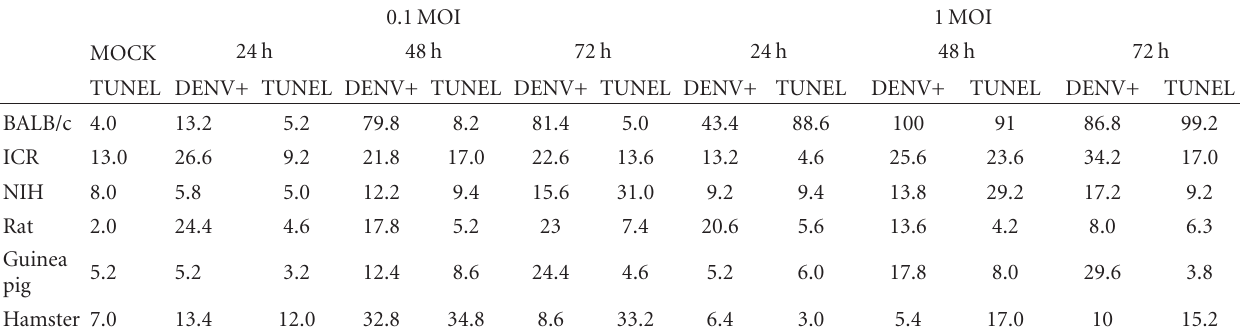
Table 1: Percentage of infected and positive TUNEL cultured macrophages from di ff erent